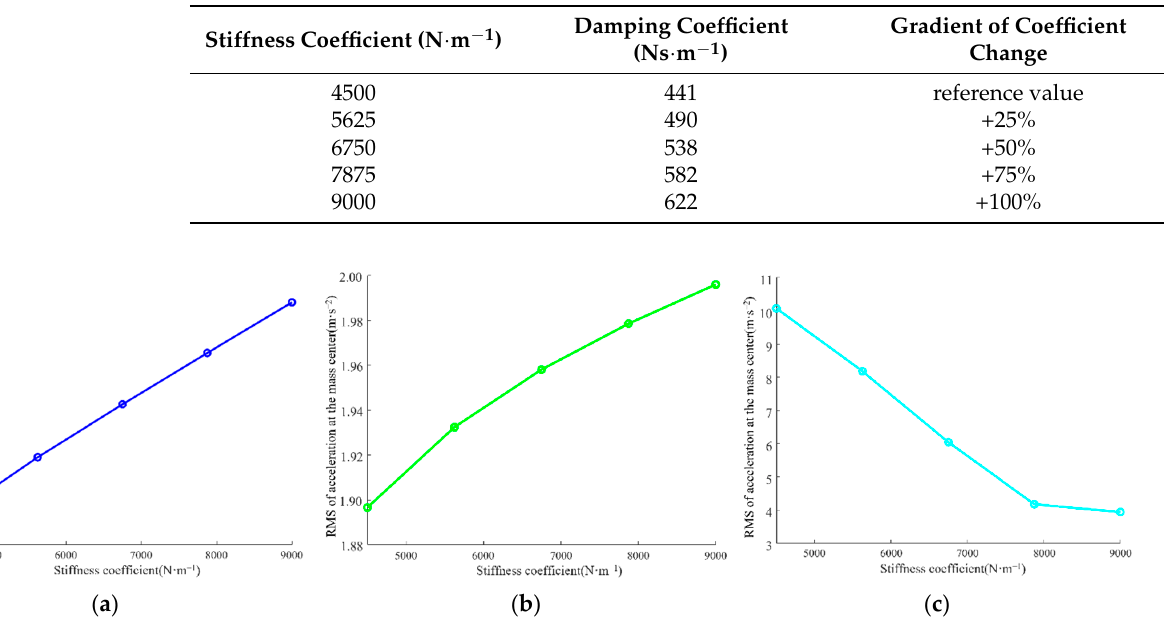
Figure 15. Stiffness change simulations comparison with bow waves. ( a ) The amplitude of 0.1 m; ( b ) the amplitude of 0.25 m; ( c ) the amplitude of 0.4 m.